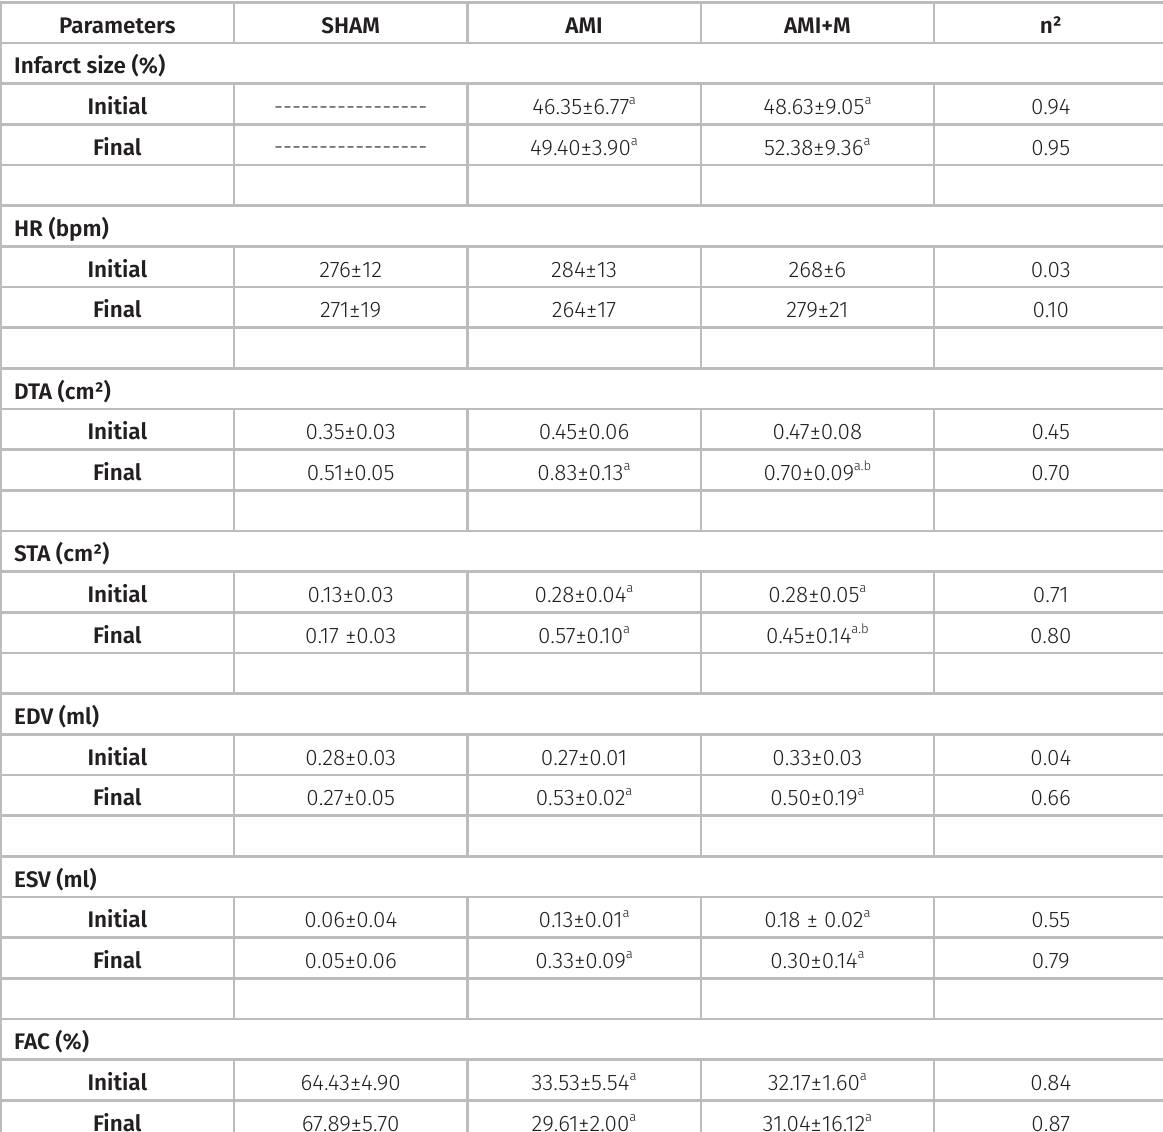
Table I. Results of initial (2 days post-AMI) and final (56 days post-AMI) echocardiographic analyses.